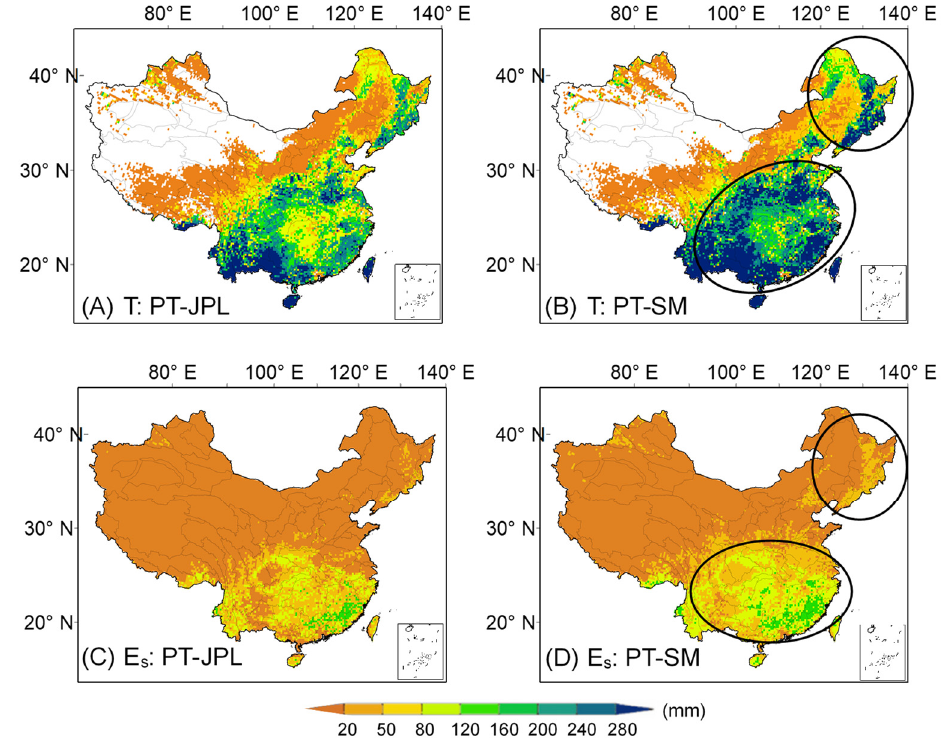
Figure 10. Comparisons of vegetation transpiration ( T ) from the original PT–JPL algorithm (PT–JPL) ( A ) and updated PT–SM algorithm ( B ); comparisons of soil evaporation ( E s ) from the PT–JPL model ( C ) and PT–SM model ( D ) in July, 2003 across China.